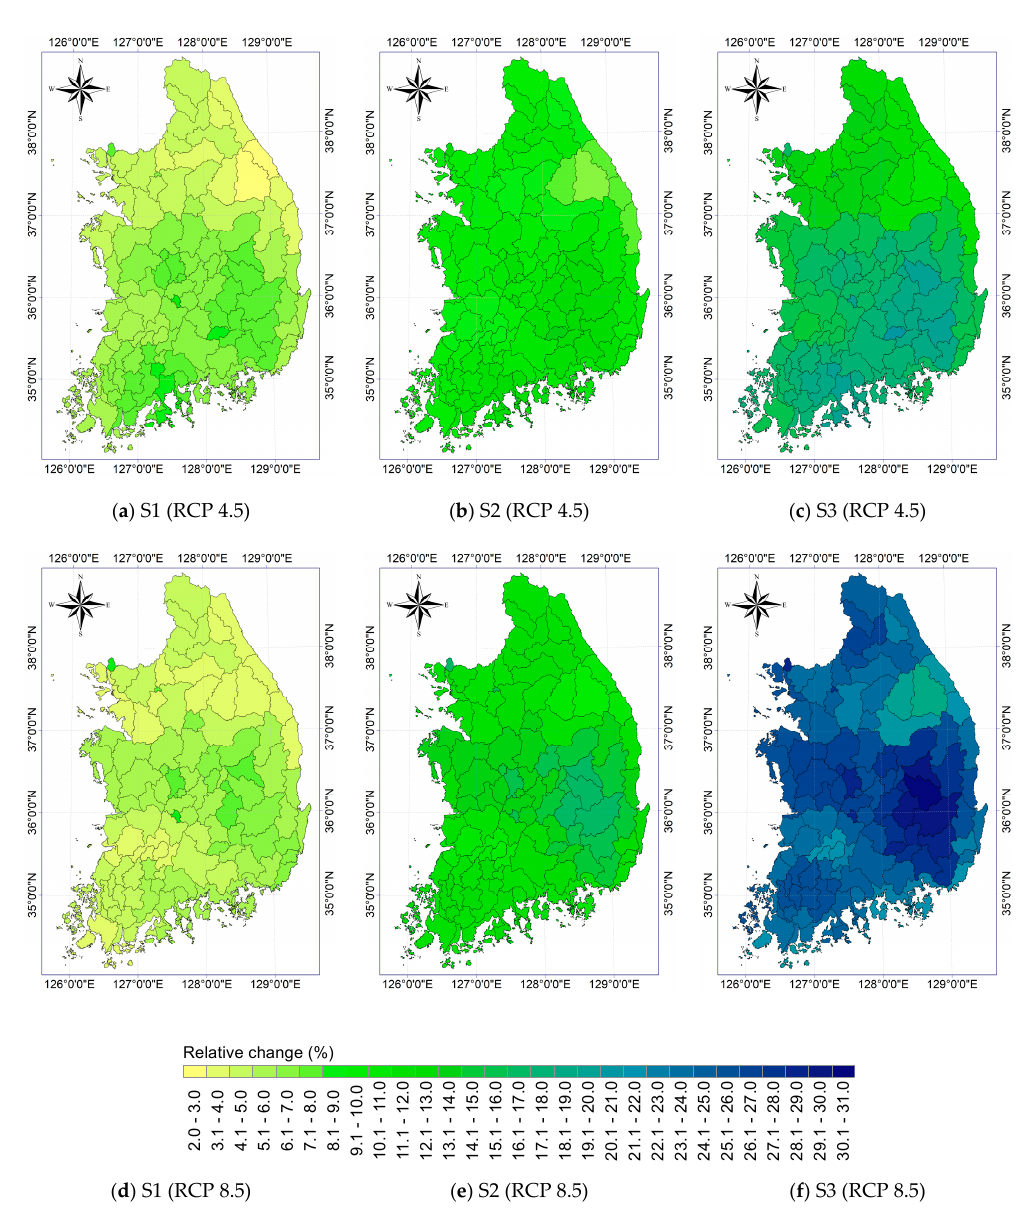
Figure 9. Relative change (%) of the 30-year average flow for 109 mid-size watersheds compared with the reference period (1976–2005) for the RCP scenarios 4.5 and 8.5 using 13 GCMs in South Korea. The values in this figure were calculated by first converting daily flow data into annual flow data. Next, the relative change of the 30-year average flow for 13 GCMs was calculated.